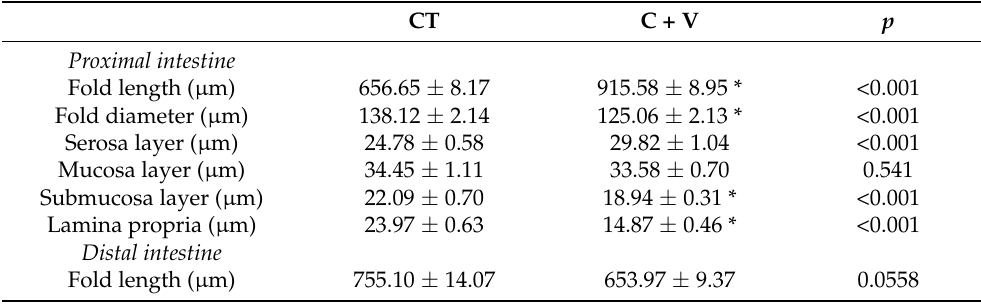
Table 9. Quantification of the histological parameters assessed ( µ m) in the proximal and distal intestinal regions of juvenile C. labrosus fed the control (CT) or C. fusca + V. proteolyticus (C + V) diets for 90